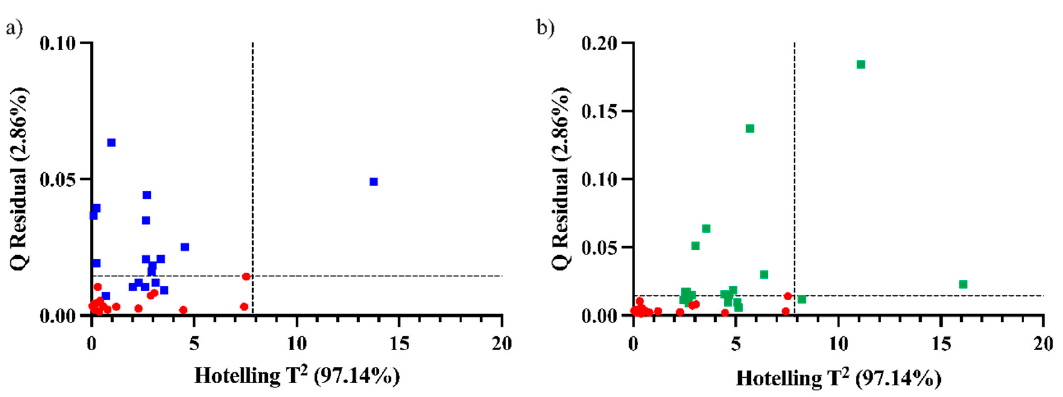
Figure 4. Q residual and Hotelling T 2 for Time 4 (red circles) and the projection in the model of ( a ) Time 3 (blue squares) and ( b ) Time 5 (green squares).